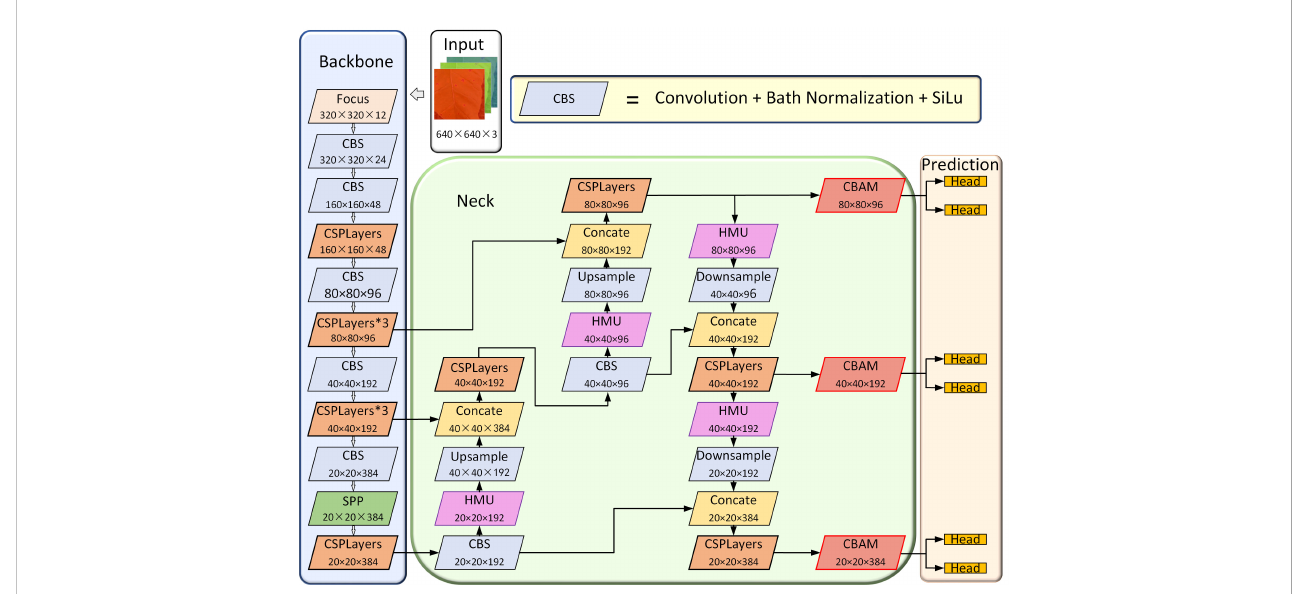
FIGURE 3 The architecture of the YOLO-Tobacco network. It consists of the input part, the backbone network part, the neck network part, and the prediction network